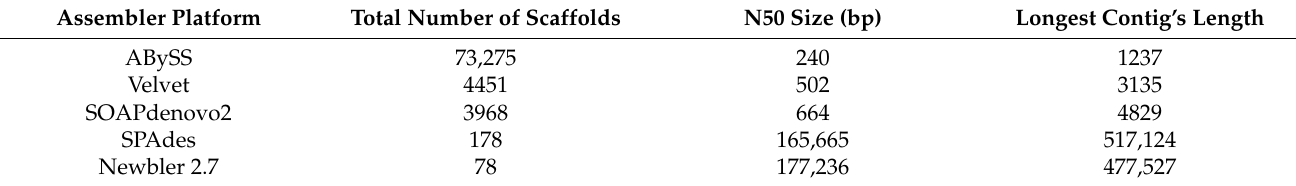
Table 1. De novo genome assembly statistics for P. bifermentans GBRC with different assembly